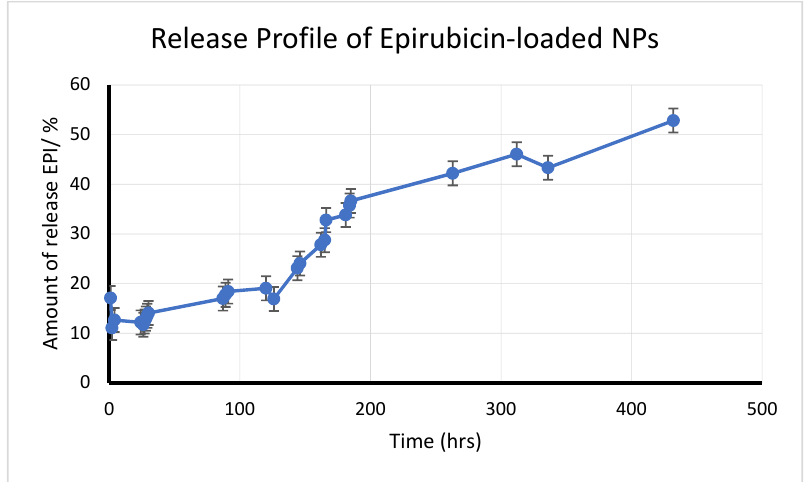
Figure 2. In vitro epirubicin release profile from EPI-NPs over a period of 432 h at 37 °C. The data represent the mean average of three measurements ± SD.